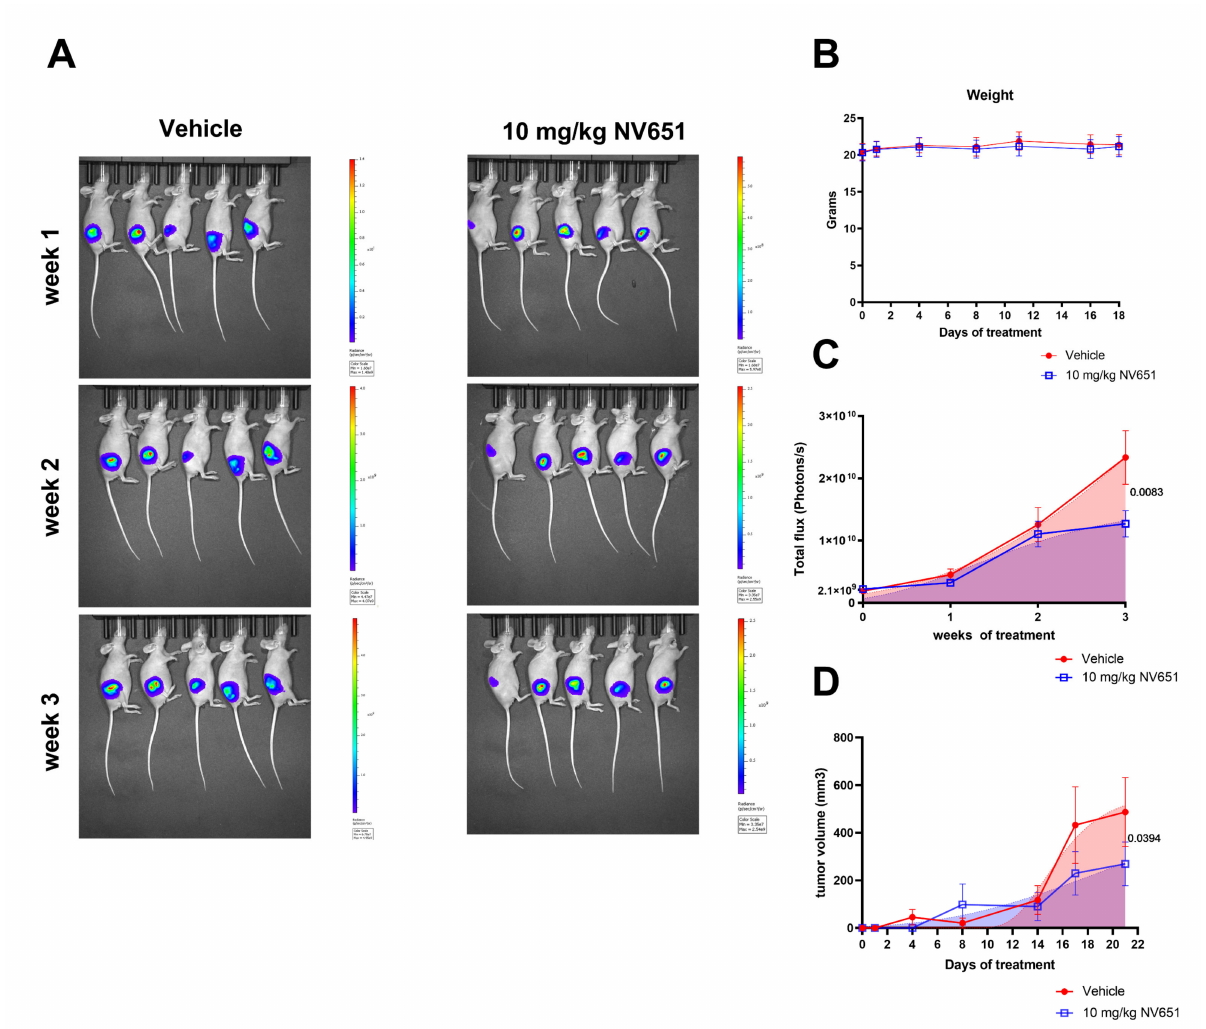
Figure 7. NV651 efficacy in nude mice xenografted with Luc+ HEPG2 cells after 3 weeks of treatment. ( A , C ) Luminescence intensity was measured once a week in the vehicle and NV651 groups for 3 weeks by the IVIS system. ( A ) Representative images of a luminescence signal in the vehicle or NV651-treated groups at 1, 2 and 3 weeks with a luminescence scale to their right. ( B ) Weight over time. ( D ) The subcutaneous tumor volumes were measured by caliper at the indicated time points. ( B ) Data were presented as the mean ± SD and statistically analyzed by 2-way ANOVA, followed by Sidak’s multiple comparison test. ( C , D ) Data were presented as the mean ± SEM and analyzed by a nonlinear regression analysis by Gomperth Growth with the p -value indicated, n = 10 mice per